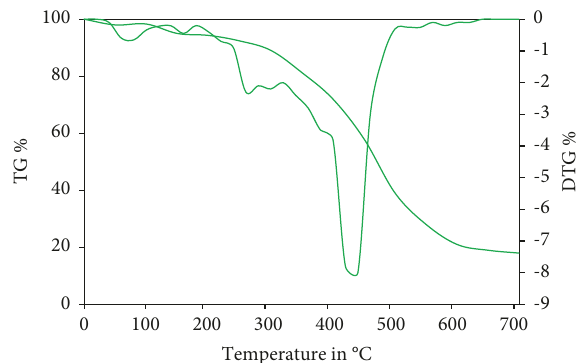
Figure 1: TG and DTG analyses of Ficus benghalensis